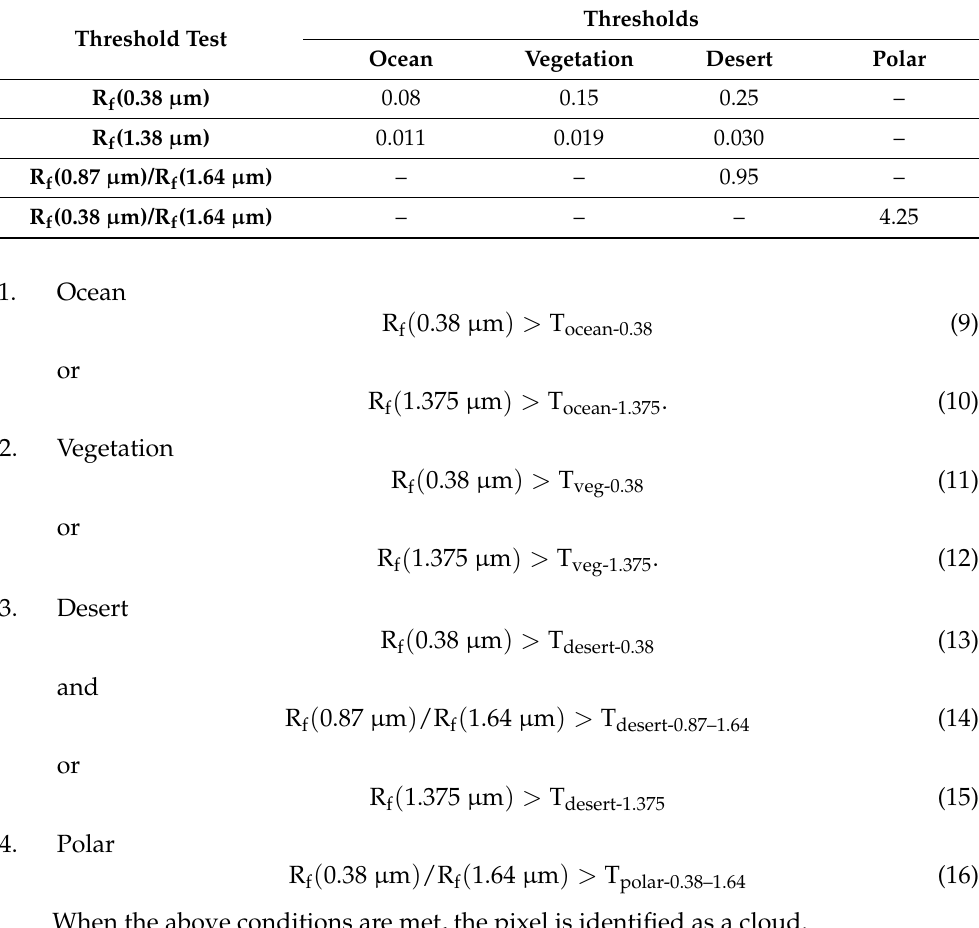
Table 3. Thresholds for cloud screening with